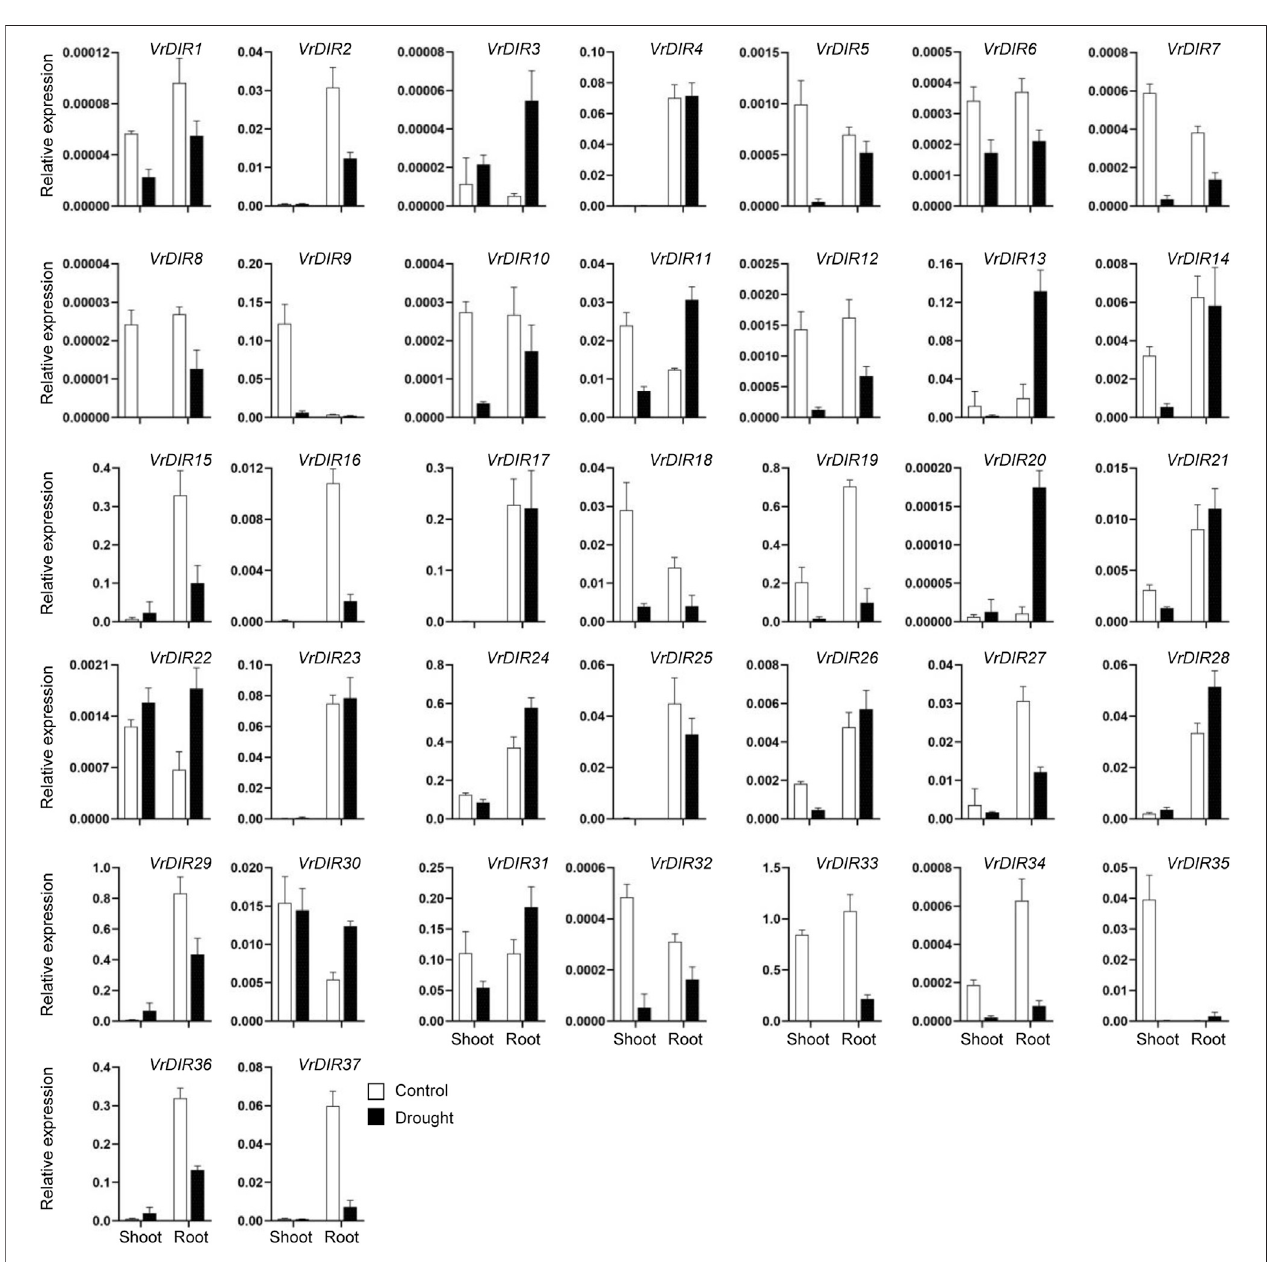
FIGURE 7 | Expression levels of VrDIR genes in response to drought stress. The expression of VrDIR genes in shoots and roots grown under normal and drought conditions was analyzed using qRT-PCR. Each sample was analyzed using three biological replicates and normalized to an Actin -expressing gene in mungbean.